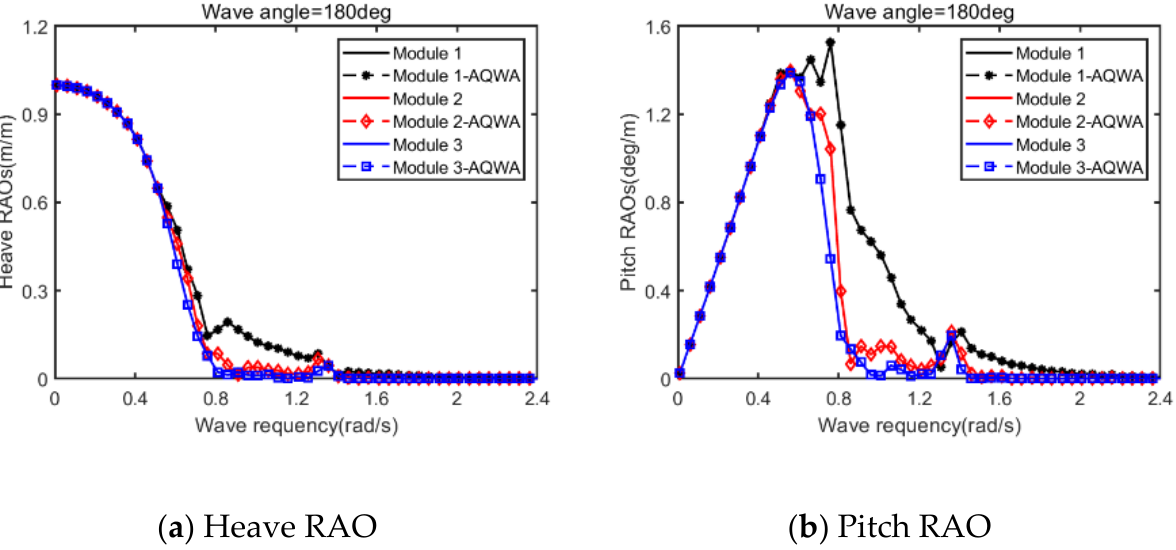
Figure 7. Comparison between the developed numerical model and the well-proven panel code AQWA.